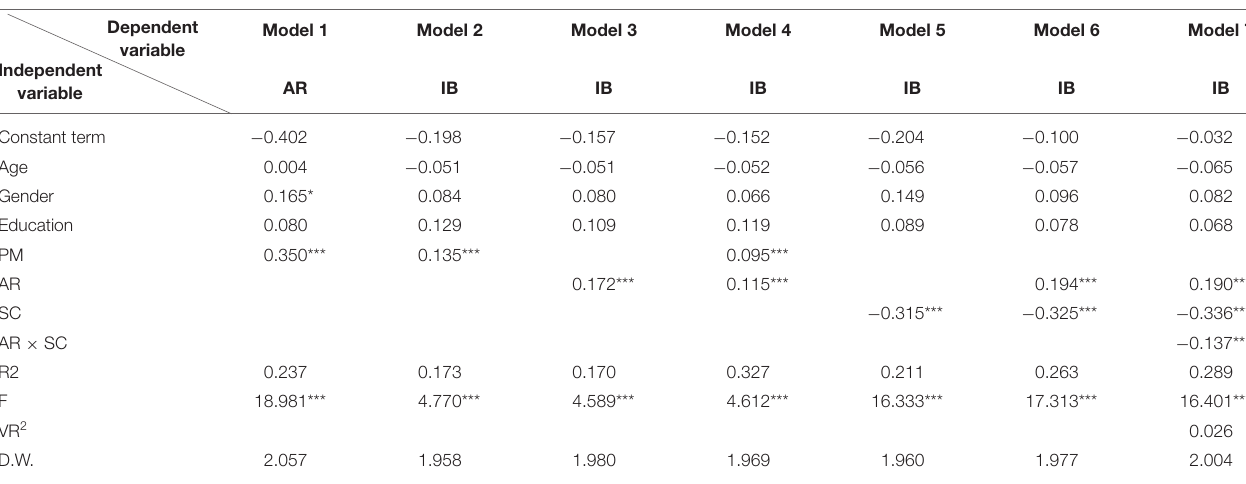
TABLE 4 | Regression analysis on hypothesis